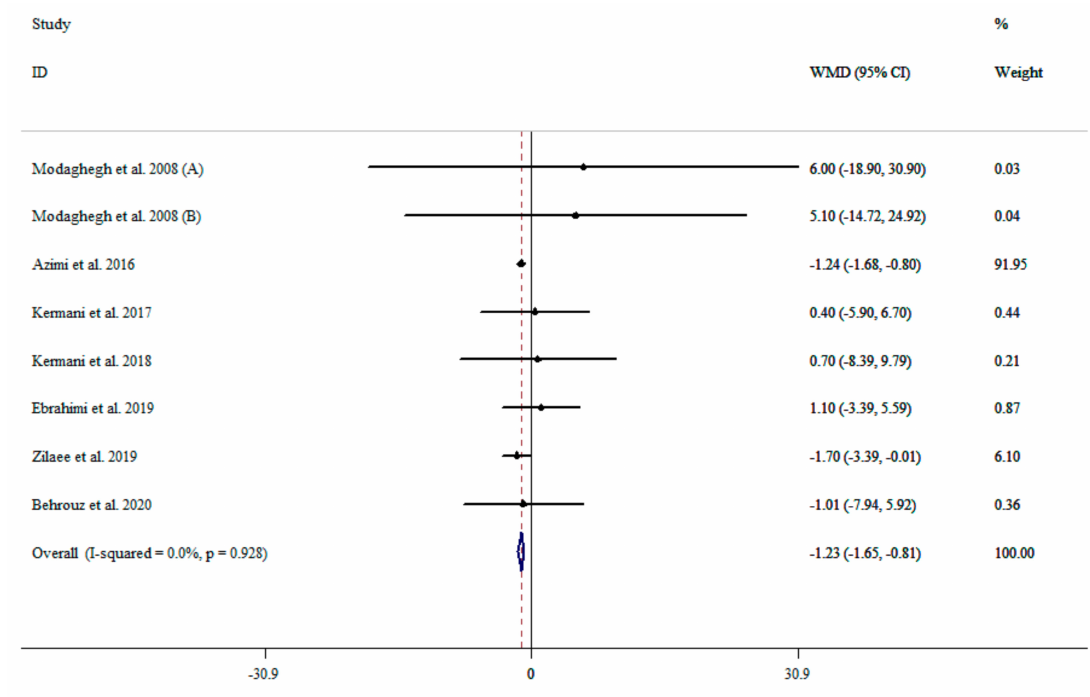
Figure 3. The effects of saffron supplementation on